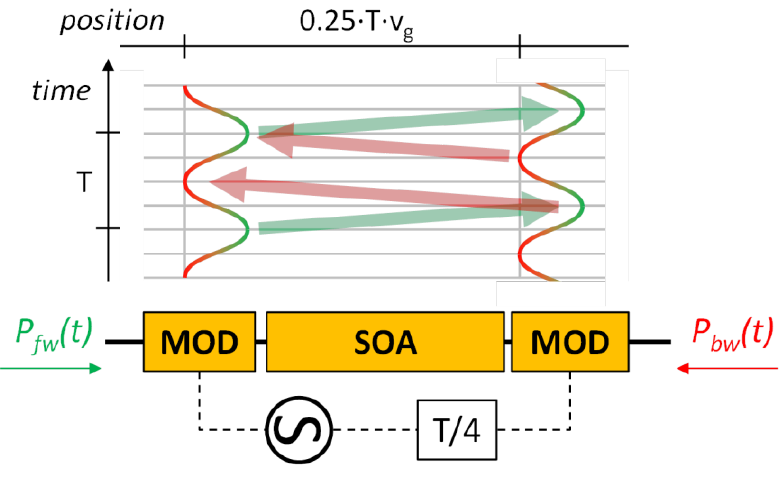
Figure 1. Schematic of the microwave photonics (MWP) isolator concept using modulators (MODs), showing the concatenated MOD-semiconductor optical amplifier (SOA)-MOD array, with the forward propagating signal P fw entering from the left and the backward propagating signal P bw entering from the right. The MOD gates are driven with a T /4 time difference, with T the period of the RF signal. The MOD transmission is indicated schematically with the sinusoid, with period T , with red indicating low transmission and green indicating high transmission. The green and red arrows are following the time-position grid and show how a forward propagating signal (green arrow) can pass two open gates, whereas a backward propagating signal (red arrow) always encounters at least on (partially) closed gate. The optical amplifier (SOA) can be used to compensate for overall insertion